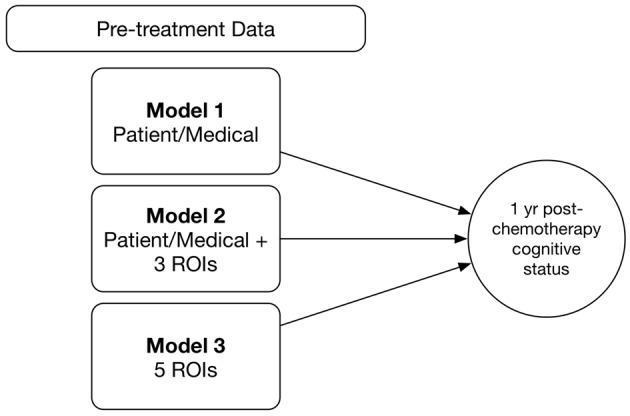
Random forest models. We tested and compared three different random forest models for predicting 1 year post-chemotherapy cognitive outcome from pre-treatment data. ROIs, connectome regions of interest.